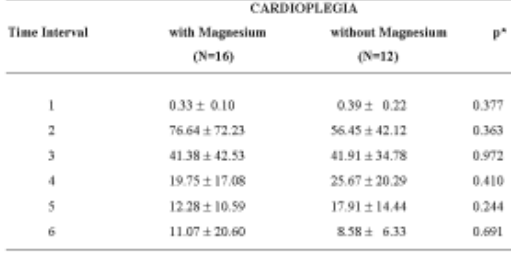
Table 1. Mean values and standard deviation of troponin I (ng/ mL) according to the time intervals and the cardioplegia used.